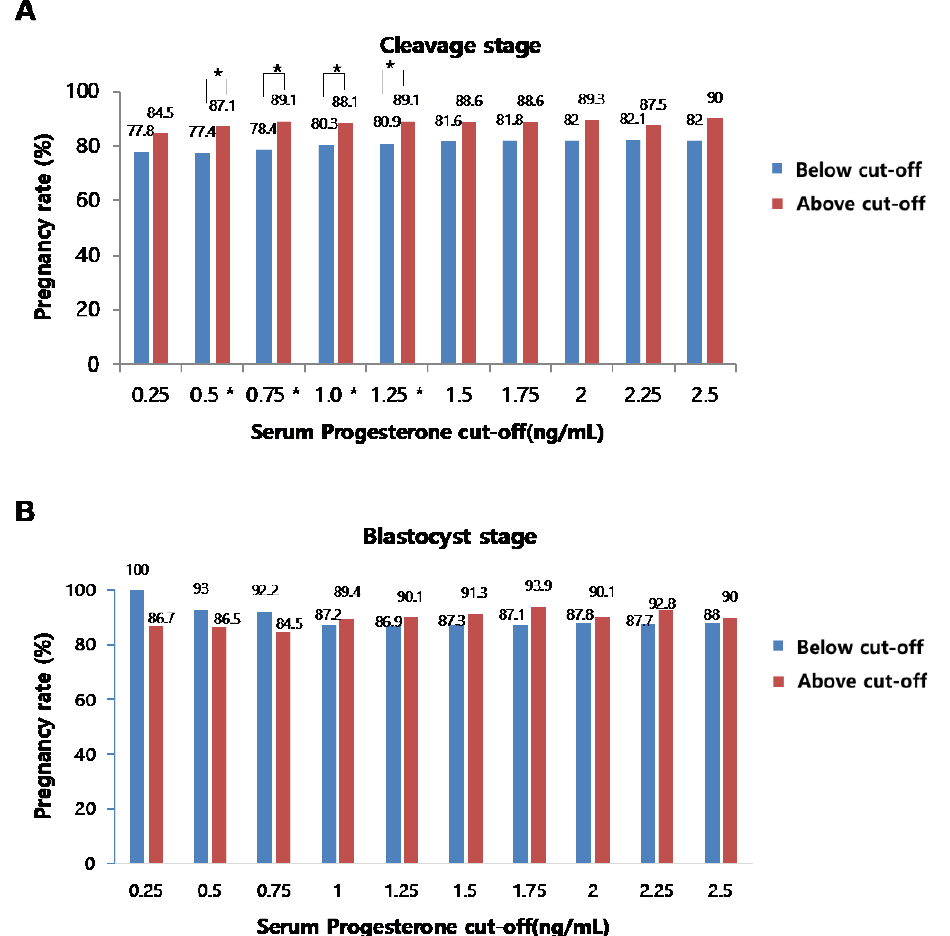
Figure 5. Correlation between serum P4 level on the day of hCG administration and the pregnancy rates at the cleavage stage ( A ) and blastocyst stage ( B ) ( p < 0.05(*)).